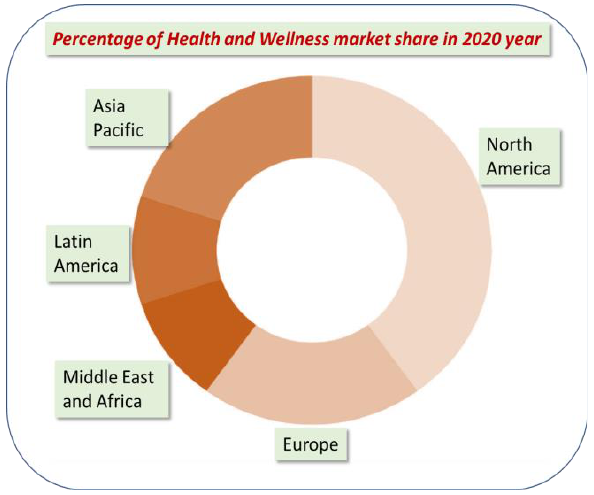
Figure 10. Forecasted health and wellness market size, from 2020 to 2030, based on market data [64].